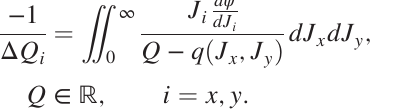
Bunch intensity